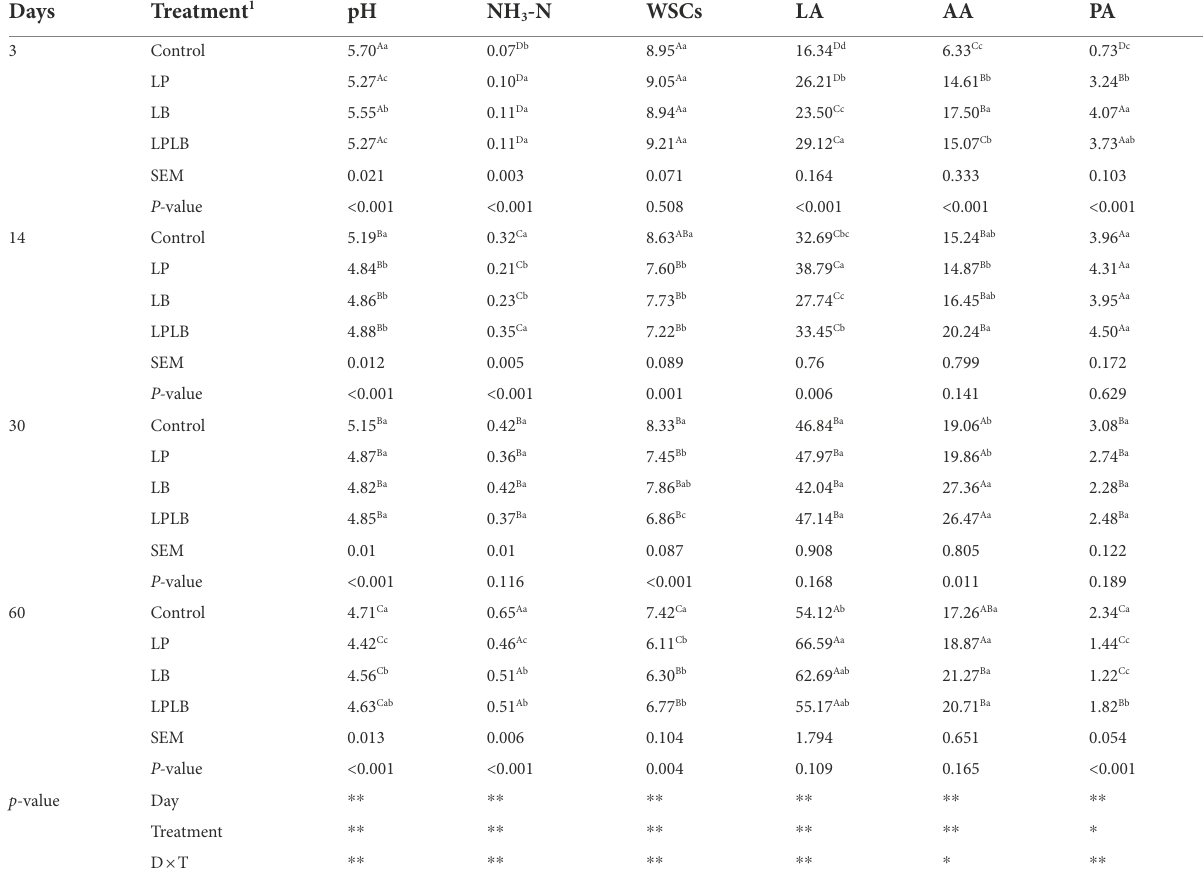
TABLE 2 Effects of Lactiplantibacillus plantarum and Lactiplantibacillus brevis on fermentation characteristics of paper mulberry